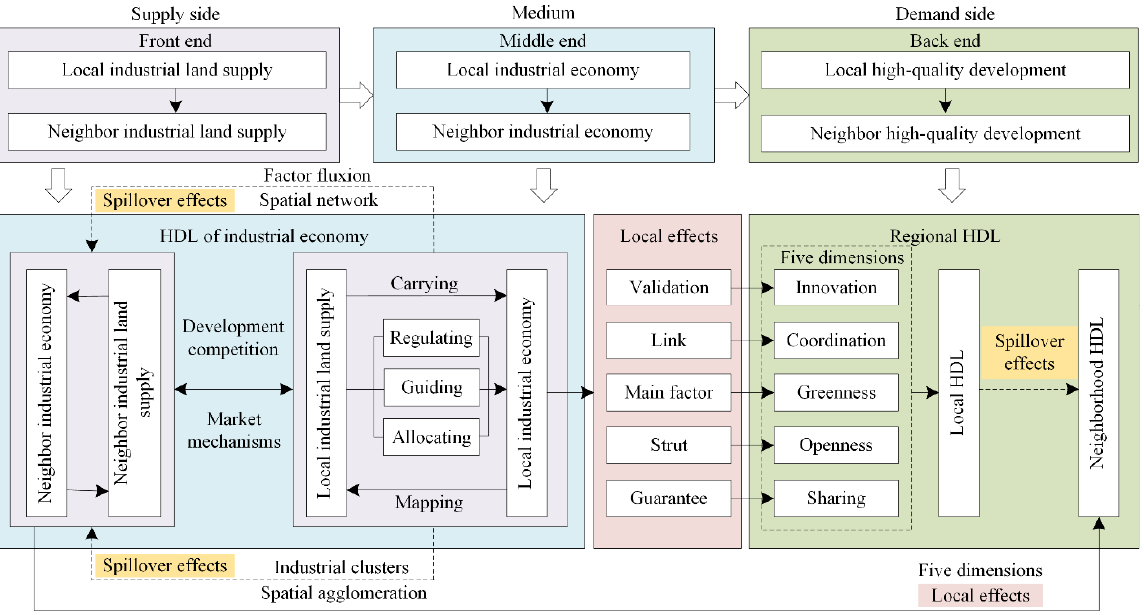
Figure 5. The impact mechanism of the industrial land supply scale on high-quality development.